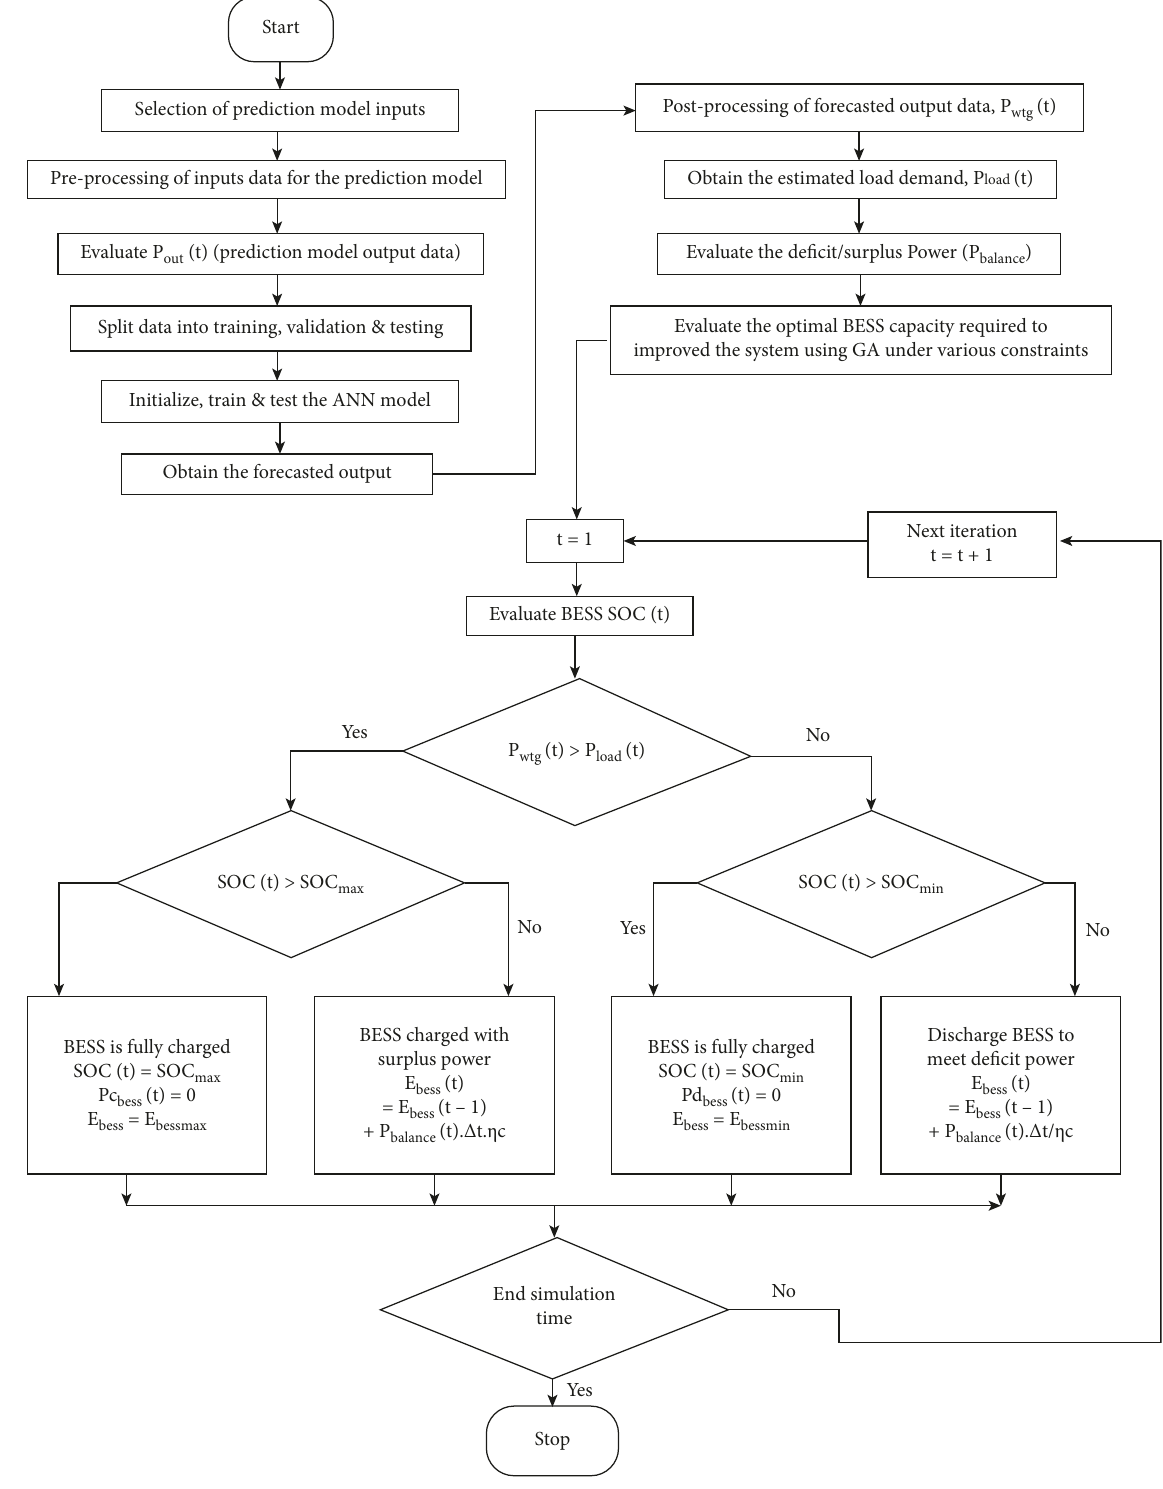
Figure 4: Proposed sizing strategy